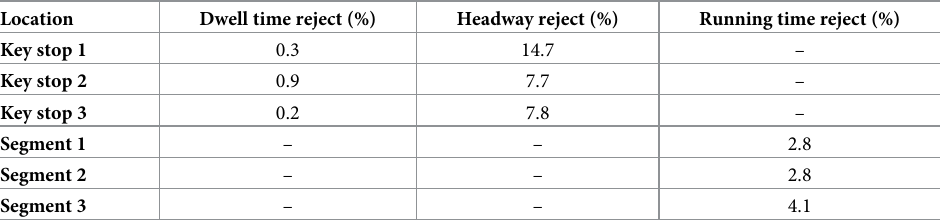
Table 9. Validation summary (Wilcoxon sign-ranked